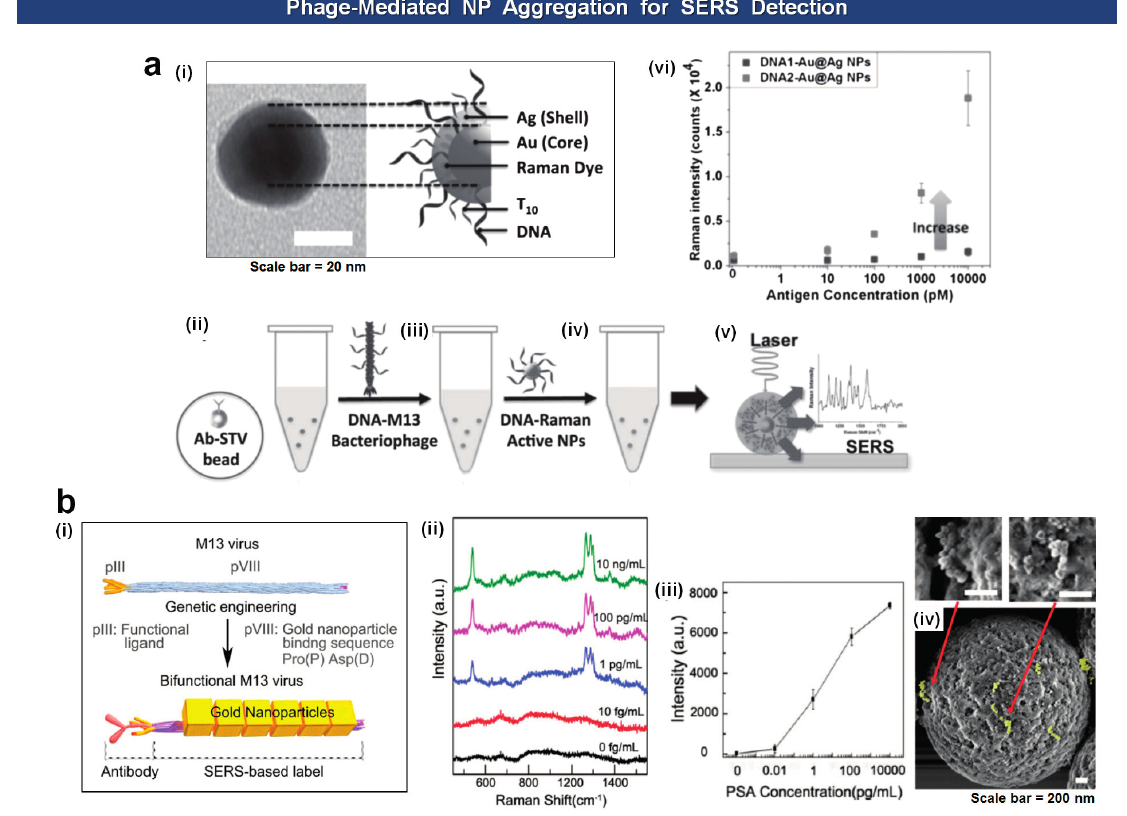
Figure 10. Phage-NPs for the SERS-based detection of analytes. ( a ) DNA-Cy3-Au@Ag (i) used in the SERS generation of bead-captured M13 virus. Panel (ii)-(vi) show working principle and enhanced detection profiles [102]; ( b ) Fabrication of phage-AuNCs hybrids (i) for the detection of PSA (ii-iii) by capturing the virus probe using magnetic beads (iv) [103] (Copyright © 2014